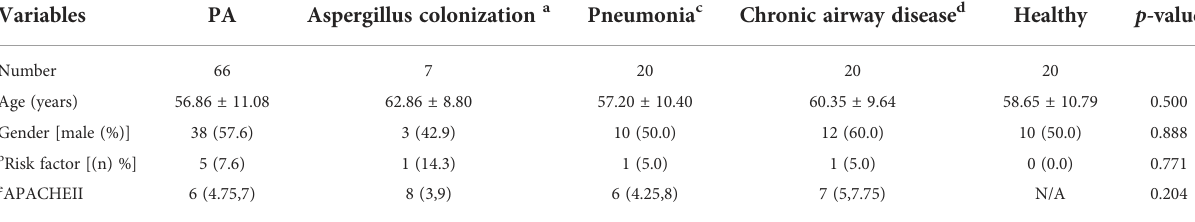
TABLE 1 Clinical characteristics of subjects included in this study.